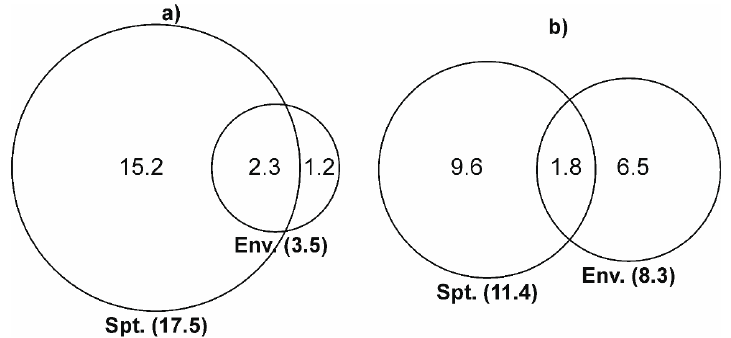
Figure 7. Variation partitioning between environmental (Env.) and spatial factors (Spt.). Venn diagrams display how much tree species variation of ( a ) seedlings and ( b ) saplings can be uniquely attributed to environmental (gap related) factors and how much variation they have in